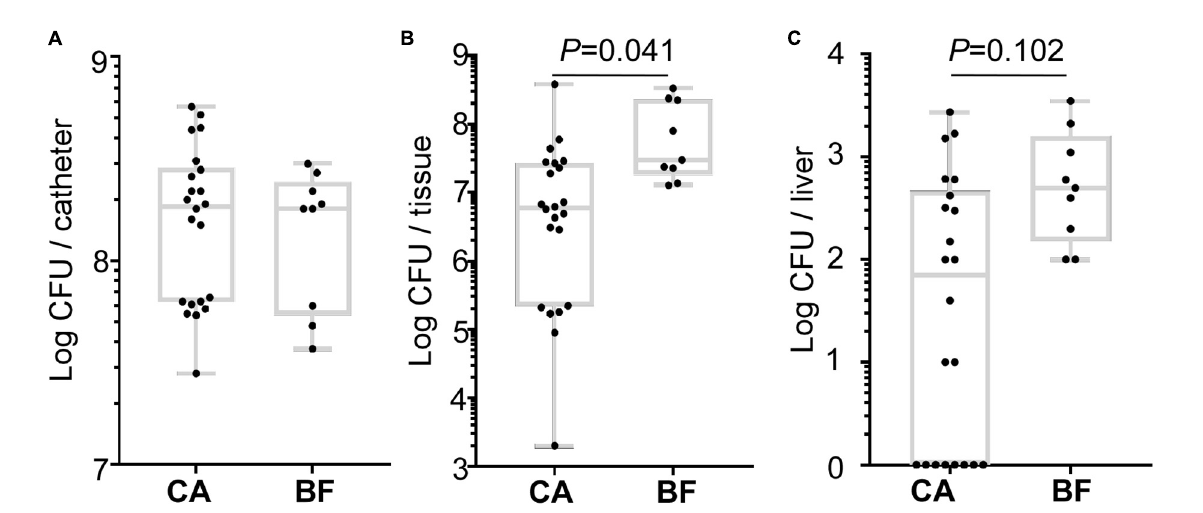
FIGURE6 Comparison of the virulence of the Staphylococcus epidermidis isolates in a murine biofilm-associated infection model. CFU from catheters (A) , peri-catheter tissues (B) and livers (C) on day 4 post-infection. The statistical significance was measured by unpaired, two-tailed t -test. Error bars show the mean ±